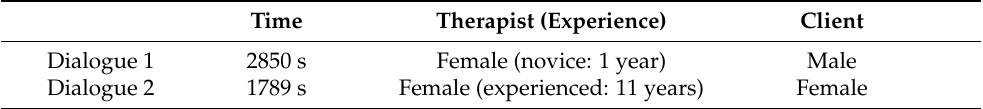
Table 1. Overview of dialogue